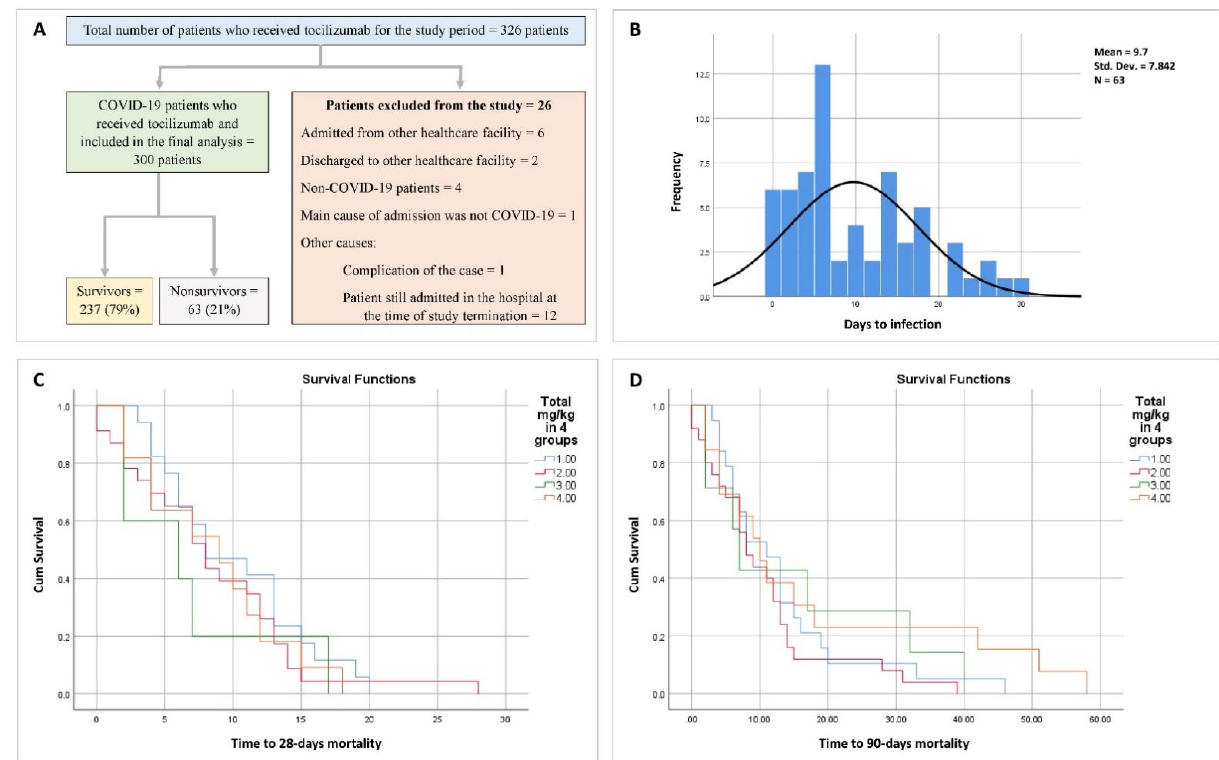
Figure 1. ( A ): Study scheme; ( B ): days to the first incidence of infection after the first dose of tocili ‐ zumab; ( C ): 28 ‐ day Kaplan–Meier survival curve integrating different dose groups of tocilizumab; ( D ): 90 ‐ day Kaplan–Meier survival curve integrating different dose groups of tocilizumab.